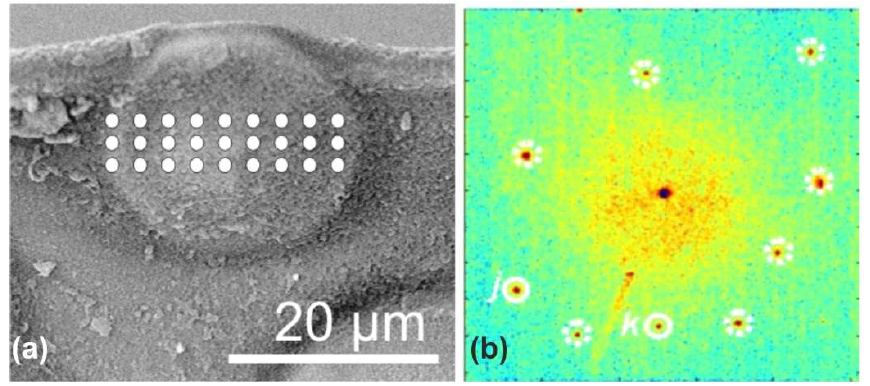
Figure A2. Disk at the growing edge of a Pinctada margaritifera shell showing the 3 × 9 X-ray diffraction spots (a ) resulting in a single-crystal like diagram ( b ). Origin ESRF Grenoble, ID 13, operator: M. Burghammer. Credit picture [25].